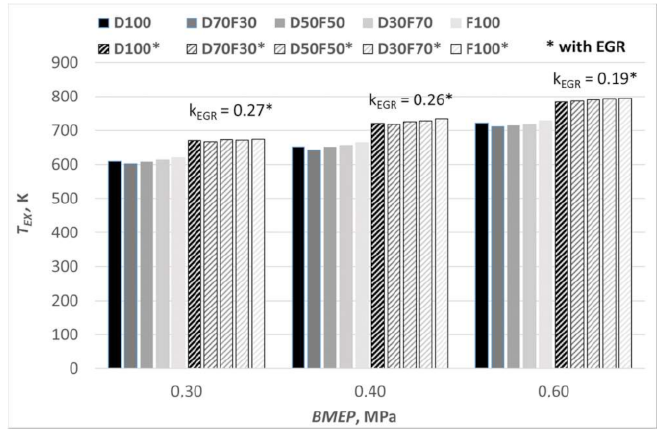
Figure 7. Dependence of exhaust temperature on fuel composition and engine load.